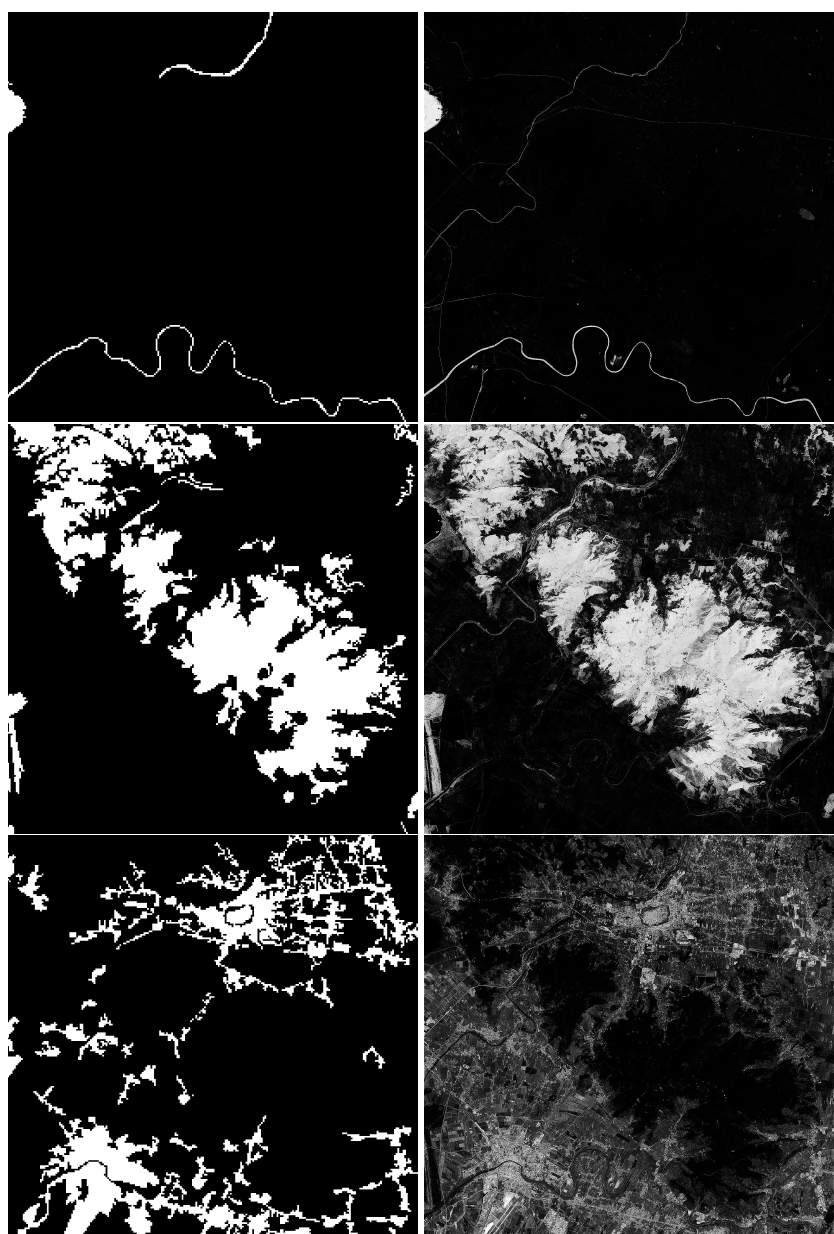
Figure 5. The reference images ( left ) and the respective images of Φ E values ( right ) for water ( top ), generic forest ( center ) and generic urban ( bottom )